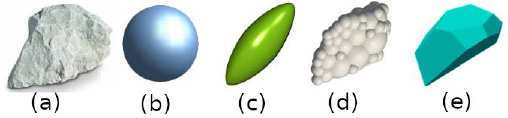
Figure 1. (a) Gravel shape, (b) spherical, (c) super-ellipsoidal, (d) clumped sphere and (e) polyhedral shape abstractions.